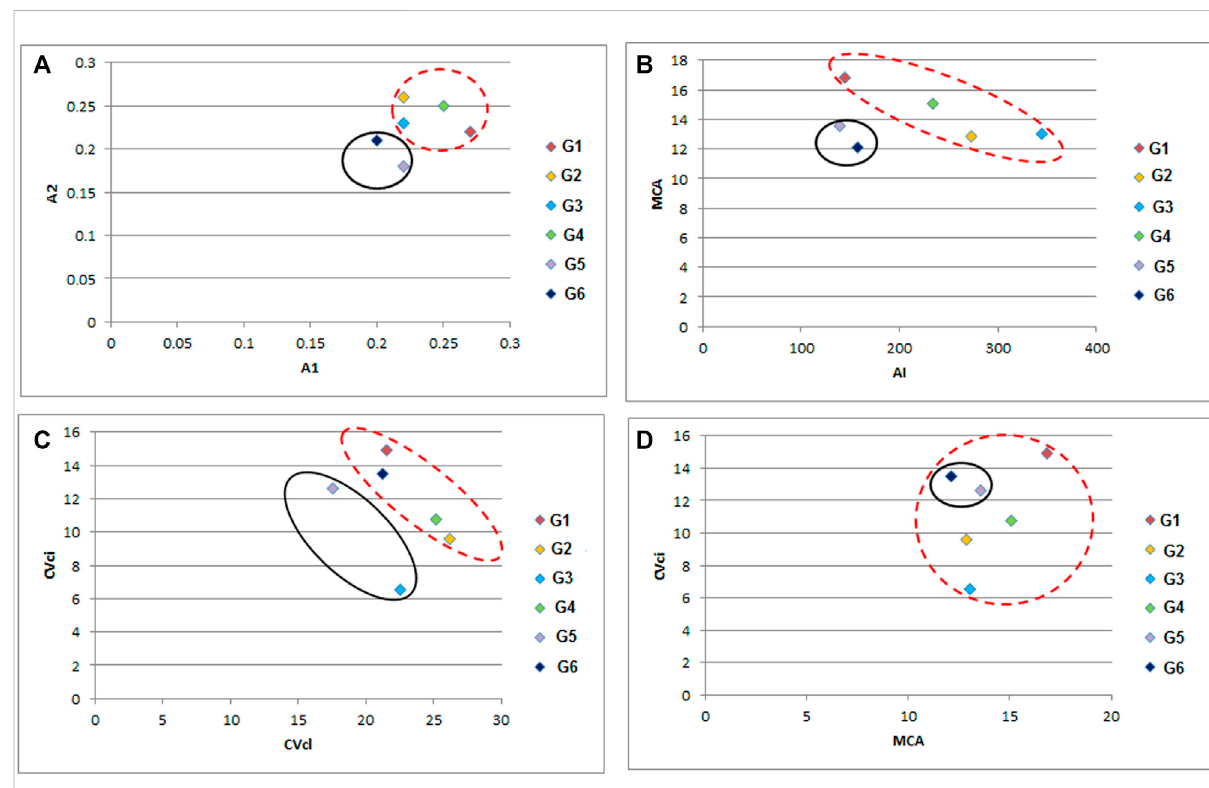
FIGURE 8 A scattered diagram of different karyotype asymmetry between different six sesame genotypes (A) A1 versus A2 parameter, (B) MCA versus AI parameter, (C) CVcl versus CVciparameter,and (D) MCA versus CVciparameter.(G1)Ahs-670,(G2)As-1236,(G3)Bah-697,(G4)Jiz-511,(G5)Jiz-517 and (G6)